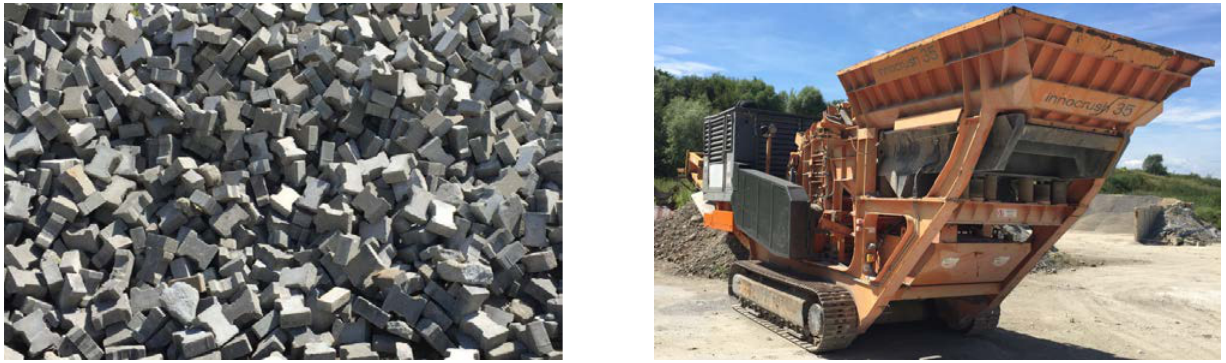
Figure 2. Concrete pavement blocks prior to their recycling ( left ) and the crushing device used for this purpose ( right ). The individual fractions after the crushing and sieving procedures are shown in Figure 3. Accounting for 24.59%, the particles smaller than 4 mm were then rejected. The concretes specimens were cast and stored in plastic cubic or cylindrical molds for the first 24 h. After preliminary curing, water evaporation was prevented by covering them with plastic lids for 7 days. The specimens were then stored in natural air-drying conditions at the temperature of (20 ± 5) ◦ C and relative humidity of (50 ±